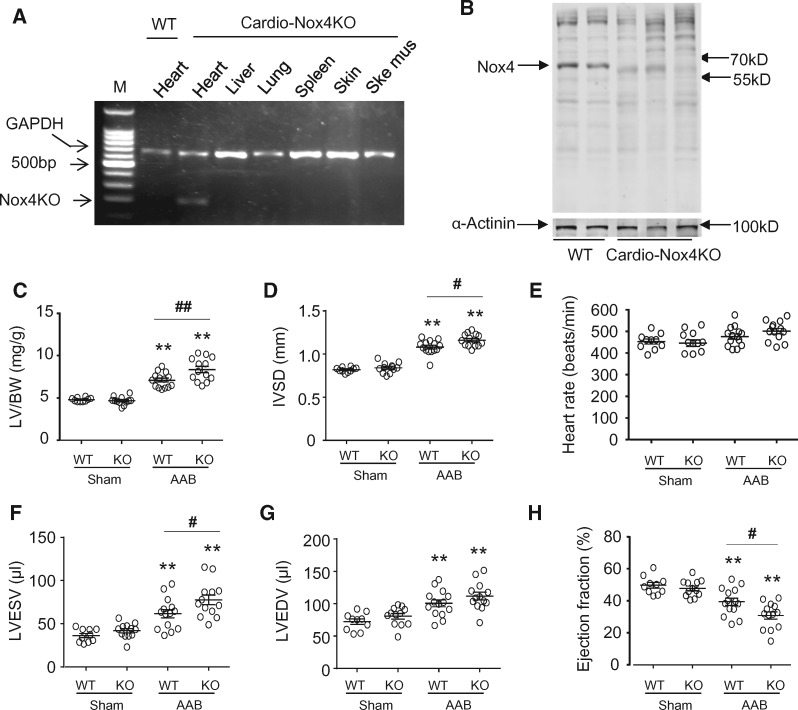
Cardio-Nox4KO mice have exaggerated cardiac dysfunction in response to pressure overload. (A) Representative image showing PCR products obtained using primers targeted against the Nox4 gene. Deletion of the first two exons in Nox4 KO tissues after 5 days of tamoxifen administration results in a truncated PCR product, which is observed only in the heart (third lane) – confirming a cardiac-specific knockout. (B) Nox4 protein levels in cardiomyocytes isolated from hearts of cardio-Nox4KO mice and wild-type controls. α-actinin was used as a loading control. (C) Left ventricle/body weight (LV/BW) ratio after 6 weeks AAB (n = 10–14/group). (D–H) Echocardiographic analysis of WT and Cardio-Nox4KO mice subjected to 6 weeks AAB (n = 10–14/group). IVSD, interventricular septal diameter; LVEDV, LVESV, LV end-diastolic and end-systolic volumes; EF, ejection fraction. **P < 0.01 vs. respective sham controls. #P < 0.05, ##P < 0.01 vs. WT/AAB, two-way ANOVA with Tukey’s Multiple Comparison Test. All data are presented as mean ± SEM.